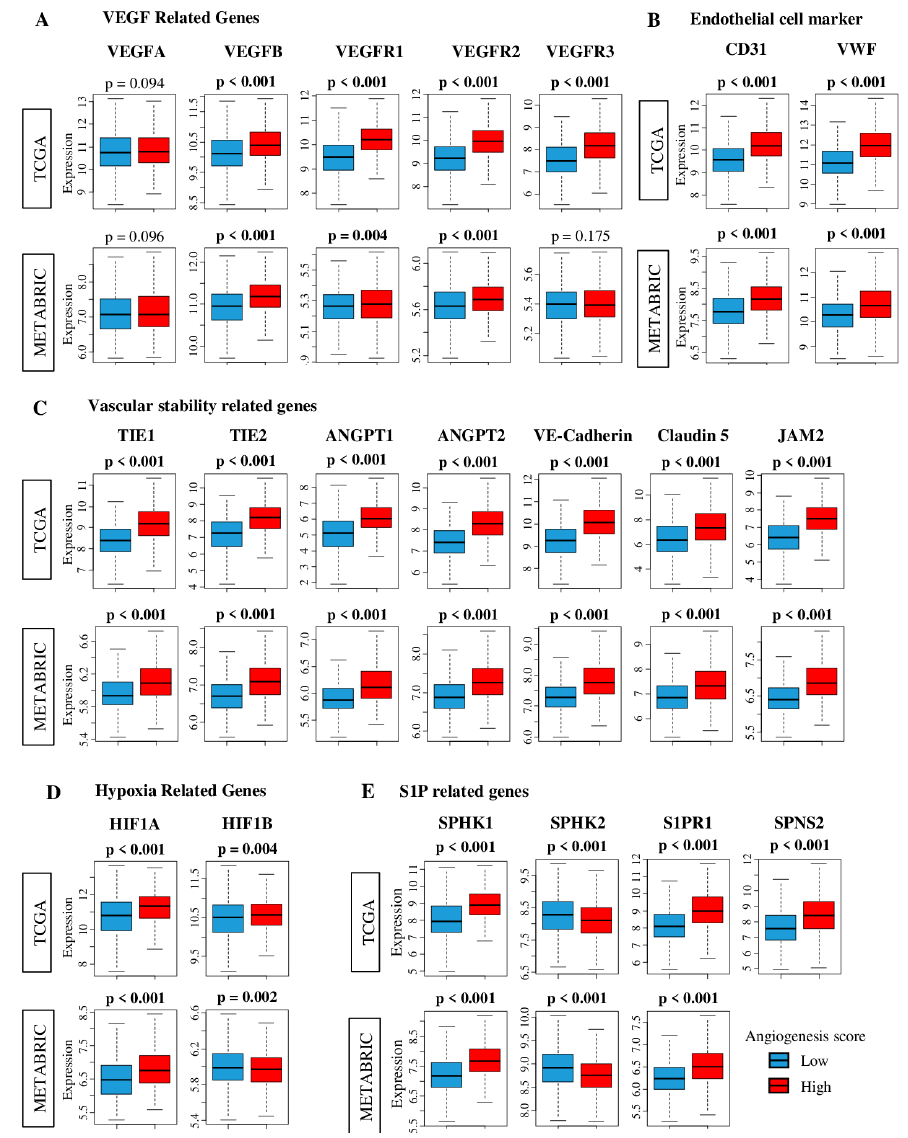
Figure 1. Association between tumor angiogenesis score and expression of Vascular endothelial growth factor ( VEGF )-, blood endothelial cell markers-, vascular stability-, hypoxia-, and Sphingosine-1-Phosphate (S1P)-related genes in The Cancer Genome Atlas (TCGA) and Molecular Taxonomy of Breast Cancer International Consortium (METABRIC) cohorts. Red and blue boxes stand for high and low angiogenesis pathway score groups, respectively. Tukey type boxplots show median and inter-quartile level values. ( A ) Gene expression levels of VEGF -related genes; VEGFA , VEGFB , VEGFR1 (FLT1 ), VEGFR2 (KDR ) and VEGRR3 (FLT4 ). ( B ) Gene expression levels of endothelial cell marker-related genes; CD31 (PECAM1 ) and von-Willebrand factor ( VWF) . ( C ) Gene expression levels of vascular stability-related genes; TIE1 , TIE2 , ANGPT1 , AMGPT2 , VE-cadherin, Claudin5 and JAM2 . ( D ) Gene expression levels of hypoxia-related genes; HIF1A and HIF1B . ( E ) Gene expression levels of S1P-related genes; SphK1 , SphK2 , S1PR1 , and SPNS2 . One-way ANOVA test was used to calculate p values. ANGPT1 / 2 ; Angiopoietin 1 / 2, CD31 (gene name: PECAM1 ), Claudin 5 (gene name: CLDN5 ), Hypoxia-inducible factor 1-alpha ( HIF1A ), HIF1B (gene name: ARNT ), SPHK1 / 2 ; Sphingosine kinase 1 / 2, SPNS2 ; Spinster homolog 2, S1PR1 ; Sphingosine-1-phosphate kinase receptor-1, TEKVE -cadherin; TIE1 ; Tyrosine kinase with immunoglobulin-like and EGF-like domains 1, Vascular endothelial cadherin (gene name: CDH5 ), Junction Adhesion Molecule 2 ( JAM2 ), VWF ; von Willebrand factor ( VWF ), VEGFR1 (gene name: FLT1 ), VEGFR2 (gene name: KDR ), VEGFR3 (gene name: FLT4 ), VEGF ; Vascular endothelial growth